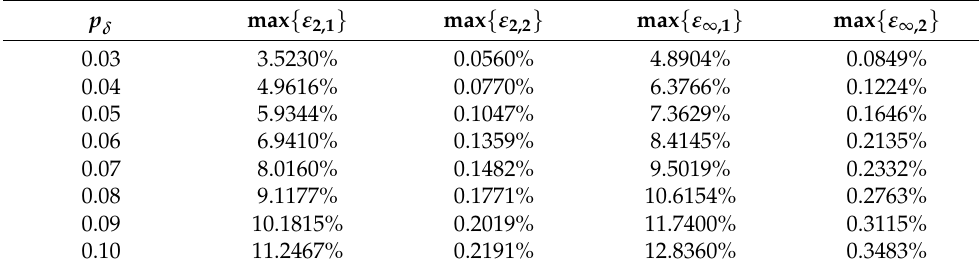
Table 1. Maximum metric values for different p δ